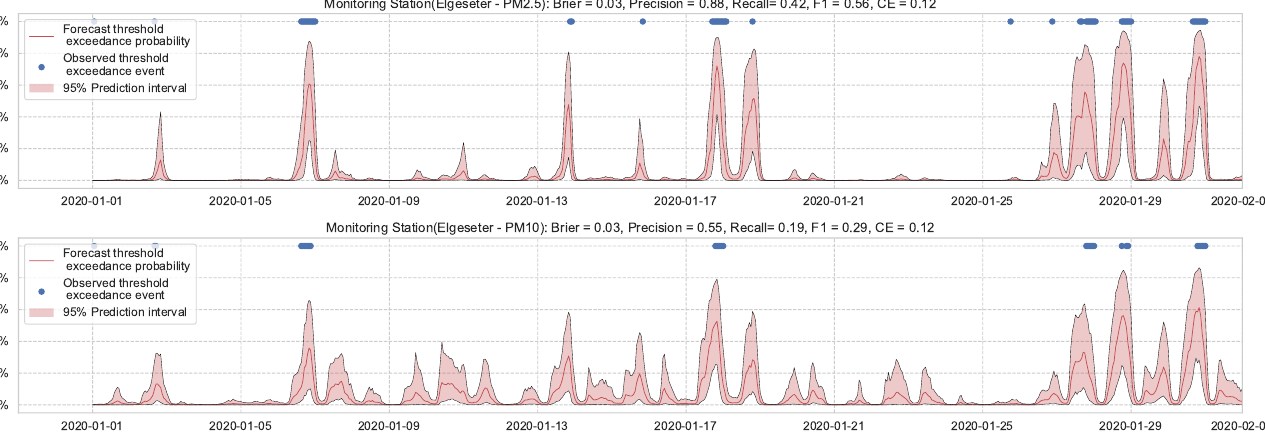
Figure 11. Predicting threshold exceedance probability of air pollutant level using a BNN